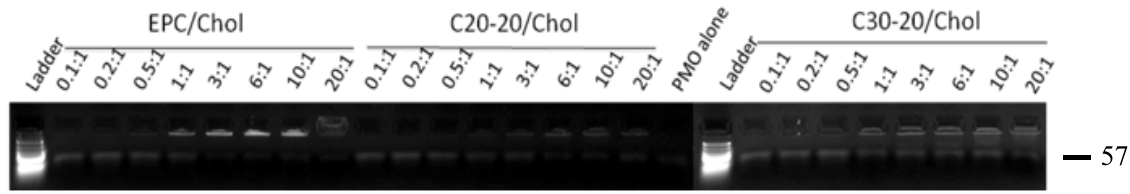
Figure 2. Gel retardation assay of EPC/Chol/PMO AO, C20-20/Chol/PMO AO and C30-20/Chol/PMO AO at (+/ − ) molar charge ratios 0.1:1 up to 20:1; low molecular